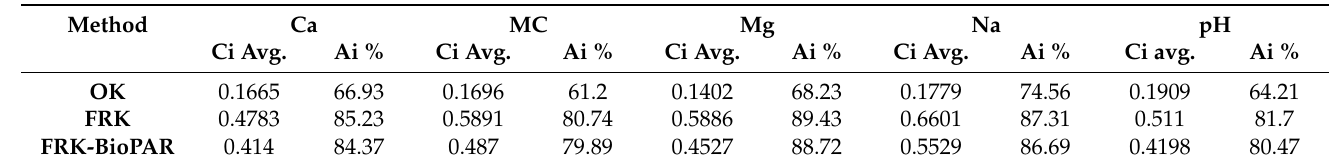
Table 10. Spatial pattern metrics of classified interpolation results: aggregation index ( Ai )% and contiguity index ( Ci ) map average (n = 4 quantile-based